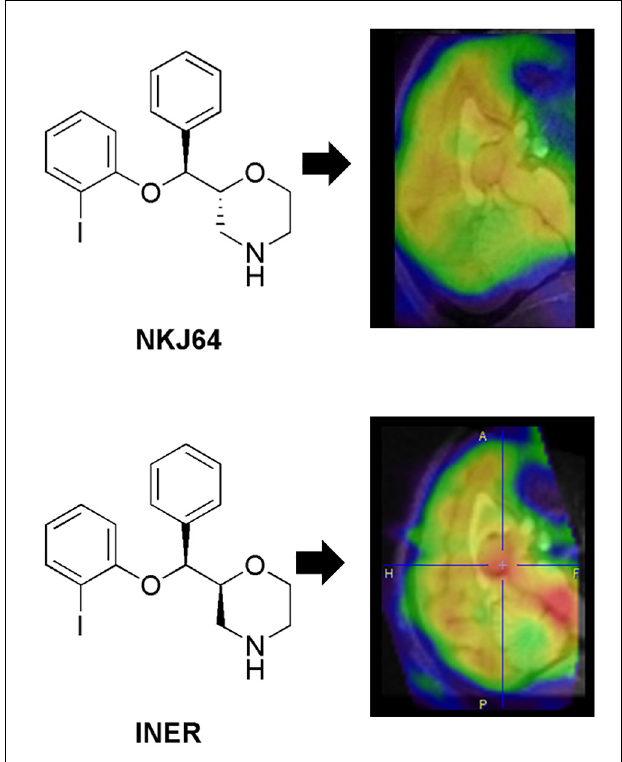
FIGURE 3 | Case study 2: Analog but different. This case study illustrates the impact of small changes in radiotracer structure on binding kinetics in vivo and subsequent impact on the translational potential of radiotracers. NKJ64 and INER were both 123 I-labeled tracers targeting the noradrenaline transporters (NAT). Both stereoisomers had nanomolar affinity in vitro , but different kinetics in vivo . The INER compound presented binding in brain consistent with NAT expression (highest in the midbrain, in particular locus coeruleus – in red), while NKJ64 had no specific binding to target in baboon brain. SPECT images co-registered to MRI data for the same baboon. A, anterior; P, posterior; F, feet; H, head.